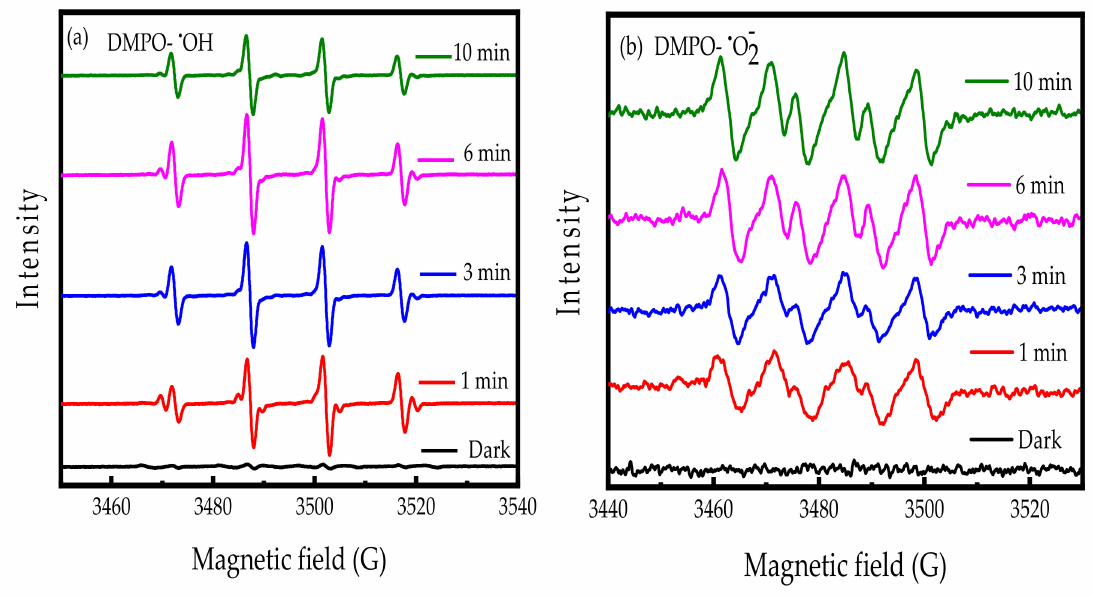
Figure 6. EPR spectra of the radical adducts trapped by ( a ) DMPO-OH in an aqueous solution, and ( b ) DMPO-O 2 − in methanol in the Cu x O/MOF